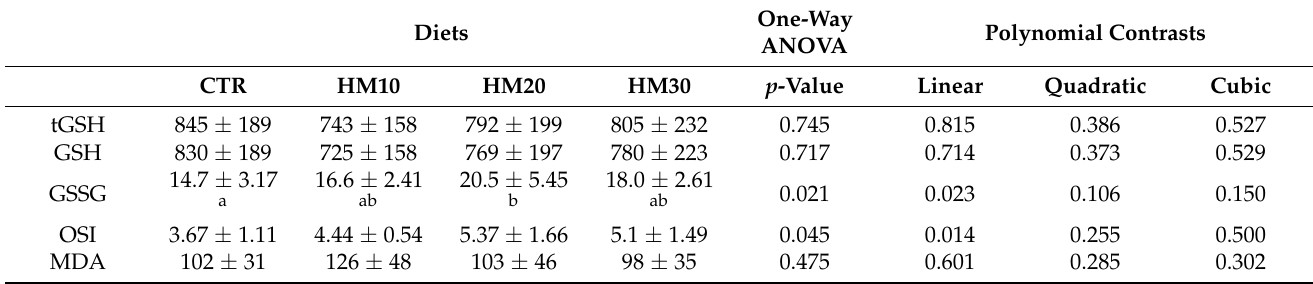
Table 4. Intestine levels of total glutathione (tGSH), reduced glutathione (GSH), and oxidized nmol malondialdehyde g tissue − 1 ) in meagre juveniles fed the experimental diets with different levels of Hermetia meal